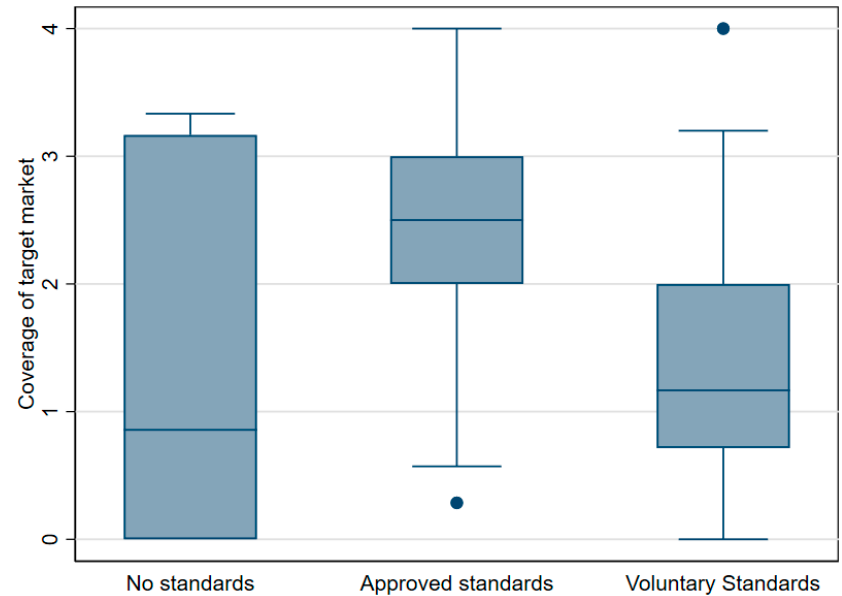
Figure 4. Box-plot showing a level of standards enacted and the coverage of target market (coverage of the target market: 0 = 0%—no production at the end of the project; 1 = 0–33% some—limited sustainable production achieved; 2 = 33–66% much—some markets supplied, but not all; 3 = 66–100% most—many markets receiving and using fortified food, but some gaps; and 4 = 100%—all domestic food of this type fortified with no subsidy). Note: the outside values are illustrated by dots. Adjacent line = upper adjacent value whiskers. The 75th percentile = the upper hinge box. The median value = dark line and the 25th percentile = lower hinge whiskers adjacent